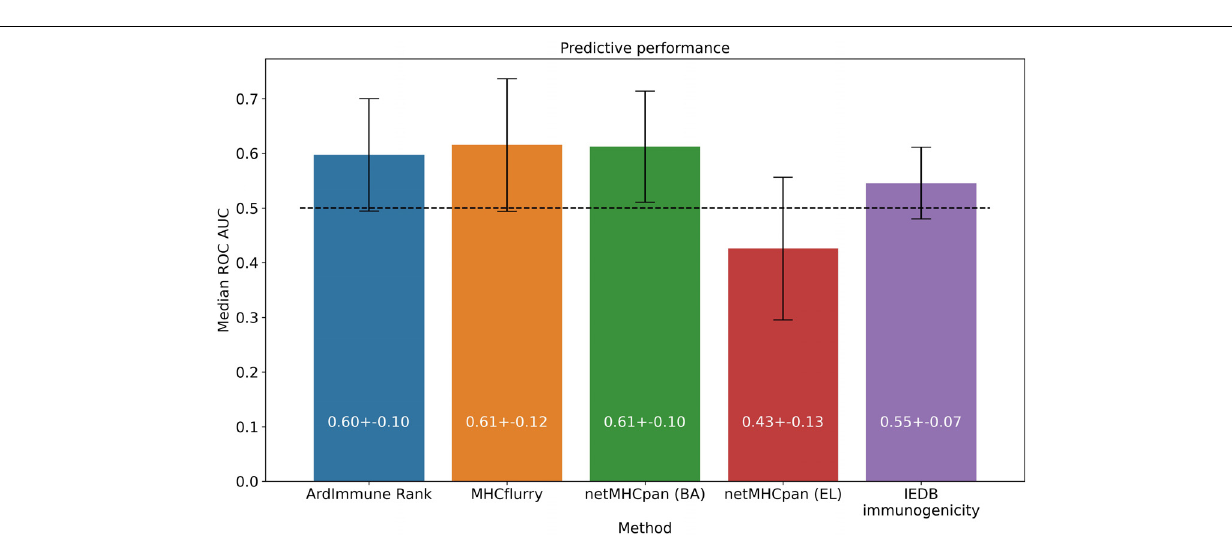
FIGURE 6 | Predictive performance of the selected models, averaged across virus groups in the training